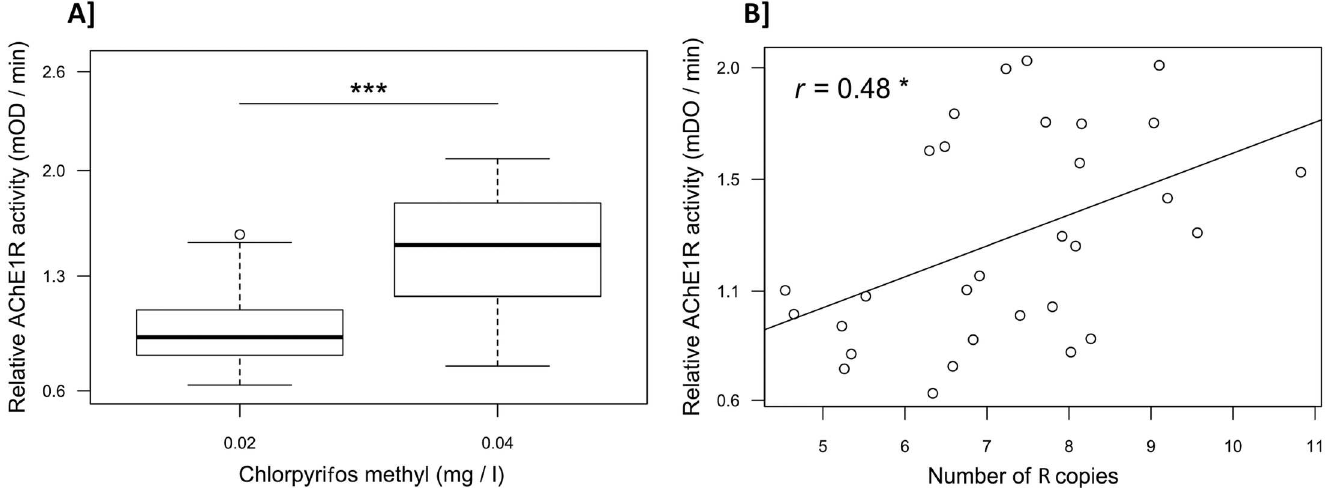
Fig 3. Relationship between AChE1 activity and insecticide resistance, or the number of R copies. (A) Boxplots present the distribution of AChE1R activity for [RR] individualsselectedat low (0.02 mg/l, n = 30) and high (0.04 mg/l, n = 30) doses of chlorpyrifos methyl. *** : Student’s t test, p < 0.001. (B) Regression analysisshowinga significantpositive relationship(GLM, * : p < 0.05) betweenAChE1R activity and the number of R copies (as the distribution by chromosome is unknown,the total number of R copies is given for each individual).Underlying data can be found in DRYAD http://dx.doi.